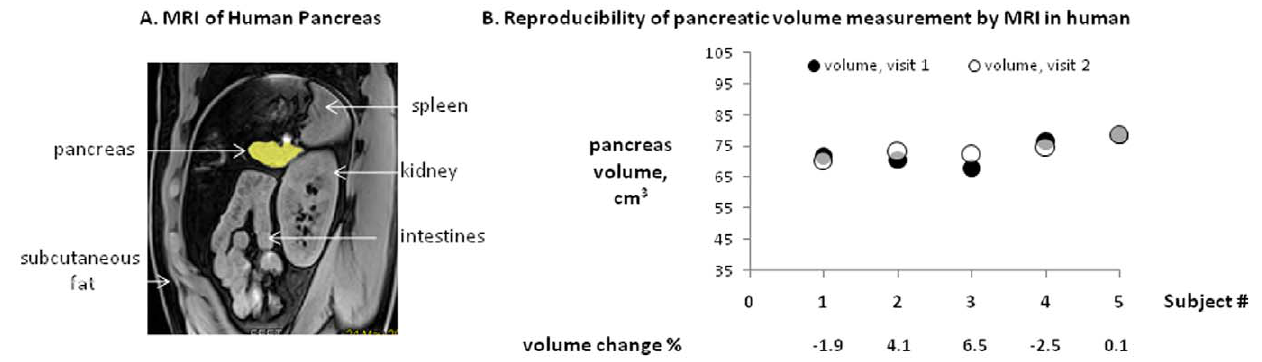
Figure 3. Human pancreas imaging. A. Representative, human abdominal image with pancreas highlighted in yellow. In average 47 slices were needed to cover entire human pancreas. The slice orientation is oblique relative to human body but it is axial relative to pancreas. B. High reproducibility of pancreatic volume measurement by abdominal MRI in 4 human subjects with the average pancreas size within 24 hours. The filled circles represent measurement at visit 1 and open circles represent measurement at visit 2, 24 hours later.